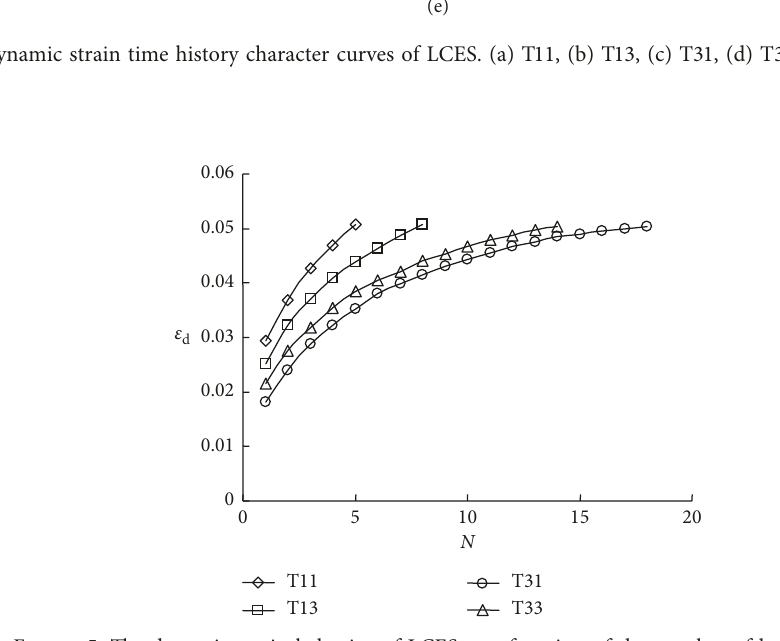
Figure 5: The dynamic strain behavior of LCES as a function of the number of load